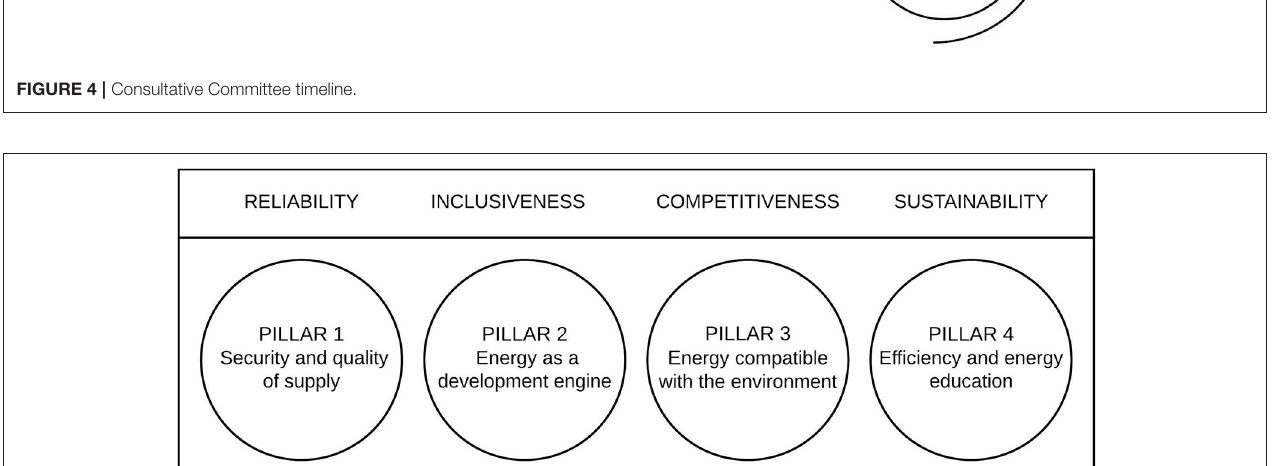
FIGURE 5 | Principles and pillars of the E2050 policy. Adapted by the authors from original in E2050 policy document.